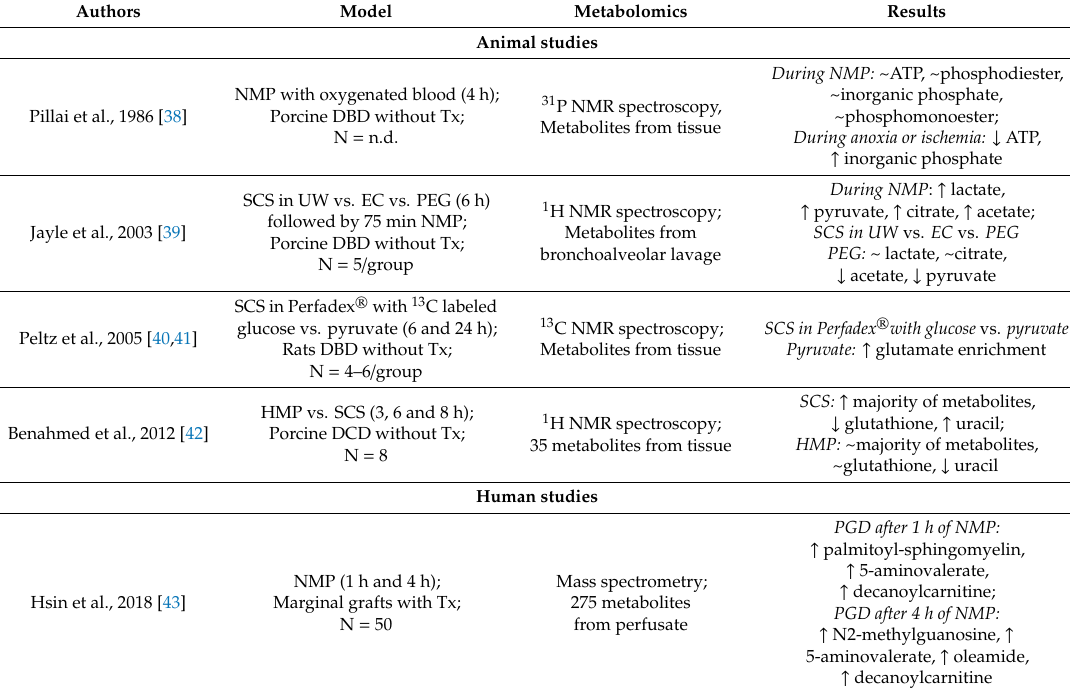
Table 2. Metabolomics in lung preservation for